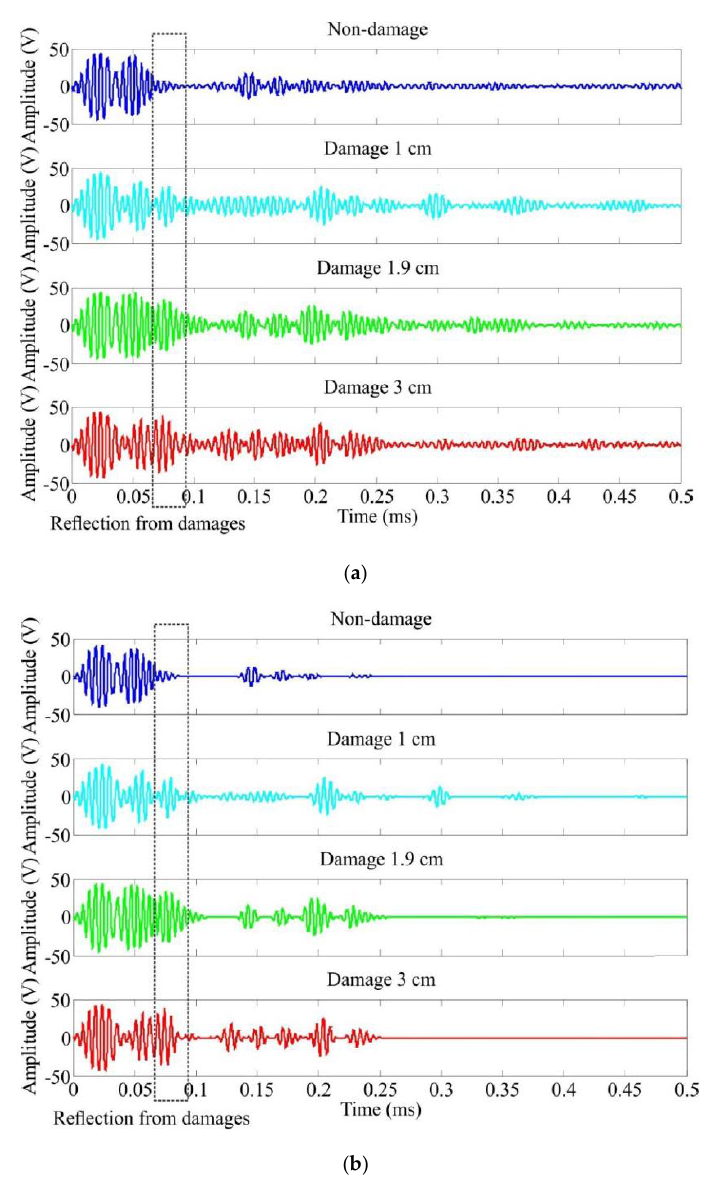
Figure 7. Multi-damage inspection comparison between two transient analysis methods ( a ) The conventional baseline method based on original signals; ( b ) The new proposed baseline method based on